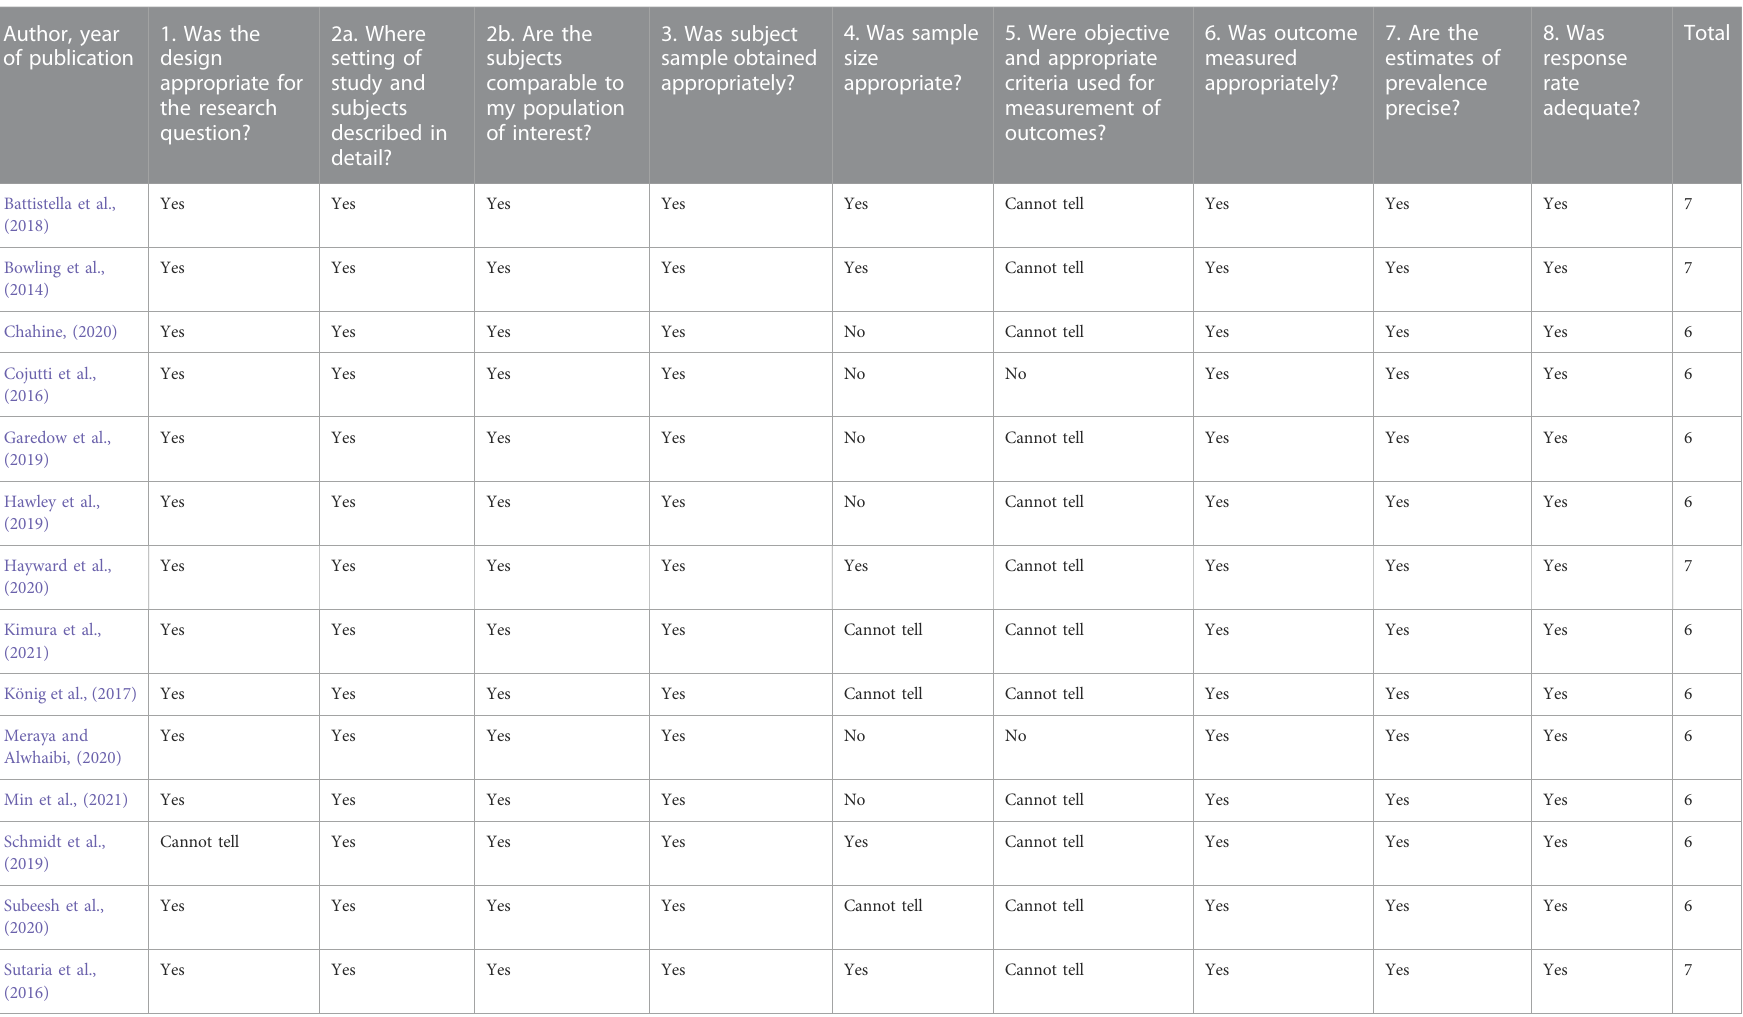
TABLE 2 Quality assessment of included